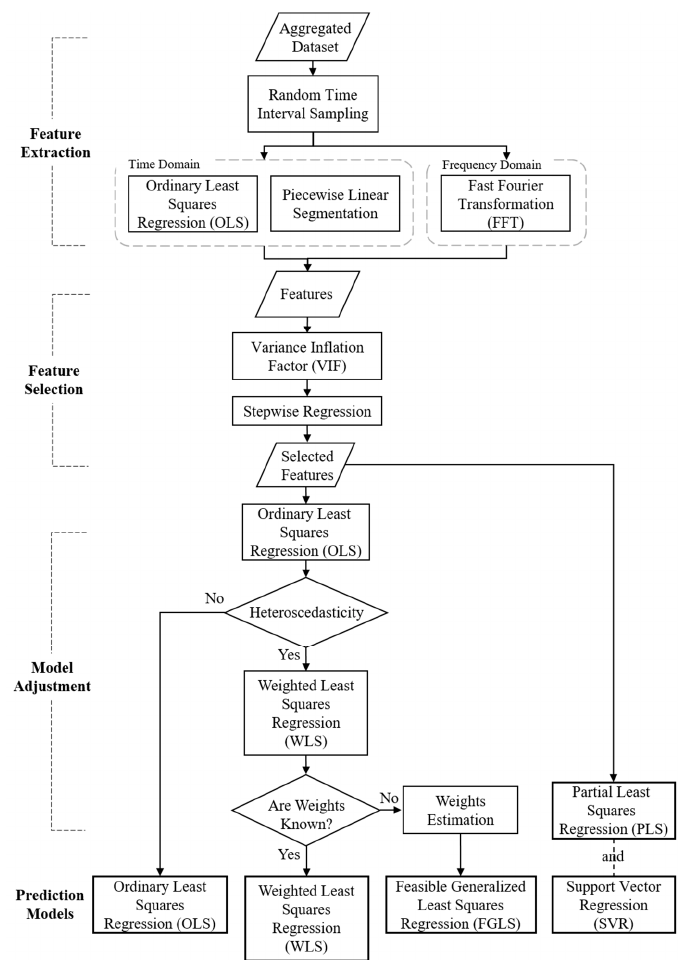
Figure 3. Feature extraction, selection and prediction